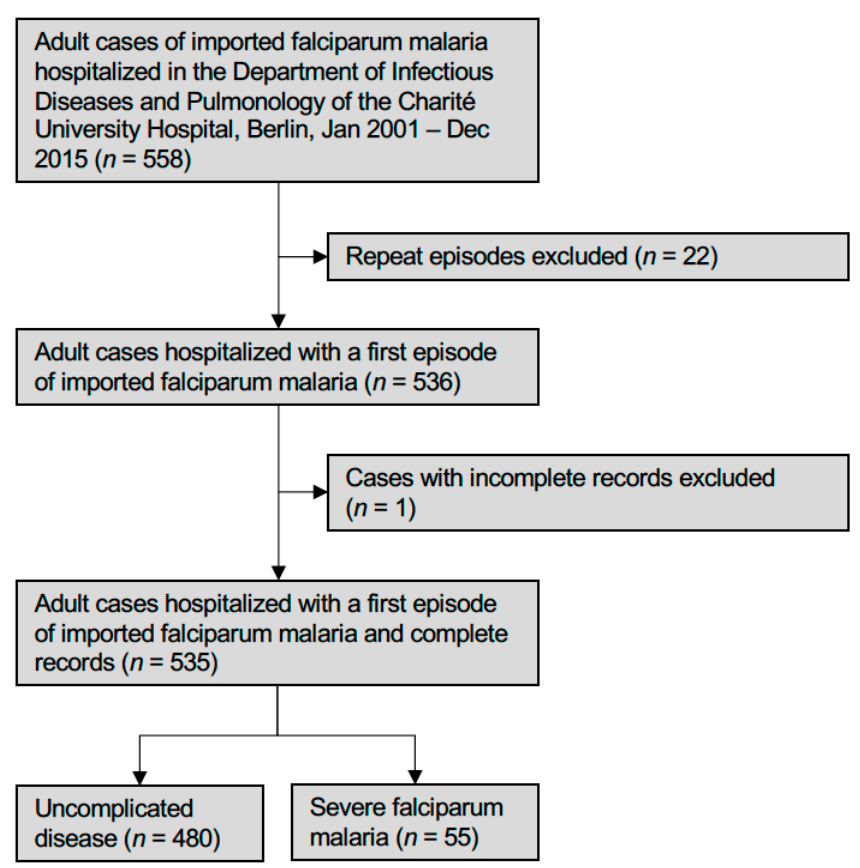
Figure 1. Flowchart of patients included and excluded.